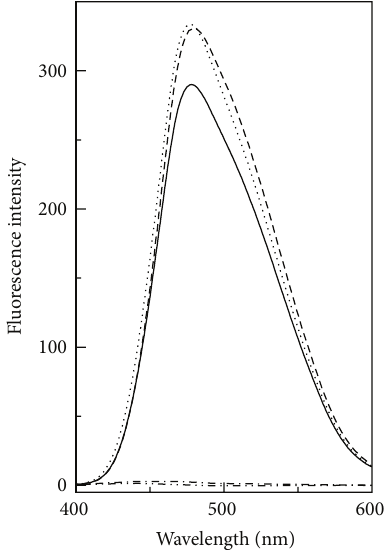
Figure 3: ANS fluorescence spectra of the acid-denatured GA in the absence (thick curve) and the presence of 2.6M GLC (dashed curve), 1.3M TRE (dotted curve), 8M GLY (dashed with one dot curve), and 8 M EG (dashed with two dots curve). The spectra were recorded at 25 ∘ C, using a protein concentration of 0.26 𝜇 M and ANS :protein molar ratio as 70